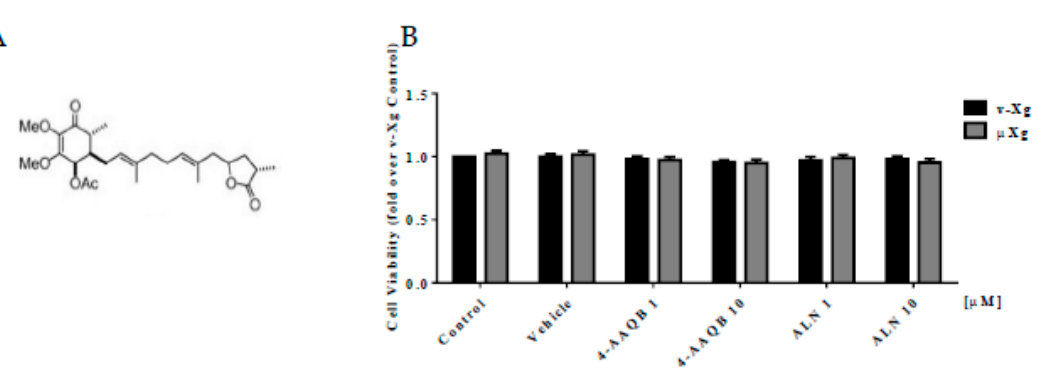
Figure 1. Effects of 4-AAQB on RAW264.7 cell viability. Chemical structure of 4-AAQB ( A ). Cell viability was assayed by alamarBlue for 2 h after cell stimulation with v-Xg or μ Xg for 24 h ( B ). The quantitative results are presented as the mean ± SEM ( n = 3).